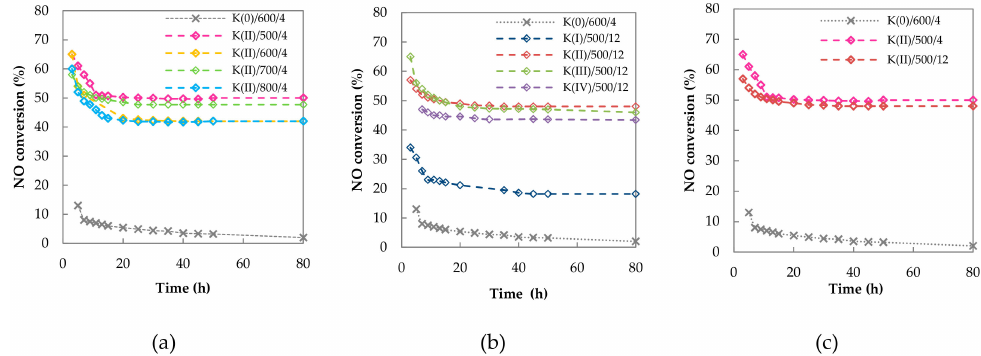
Figure 10. Long-term stability of ( a ) K(II) / y / 4, ( b ) K( x ) / 500 / 12 and ( c ) K(II) / 500 / z and K(0) / 600 / 4 in direct NO catalytic decomposition. Conditions: 1000 ppm NO balanced by N 2 , T = 650 ◦ C, Gas Hourly Space Velocity (GHSV) = 6 l g − 1 h − 1